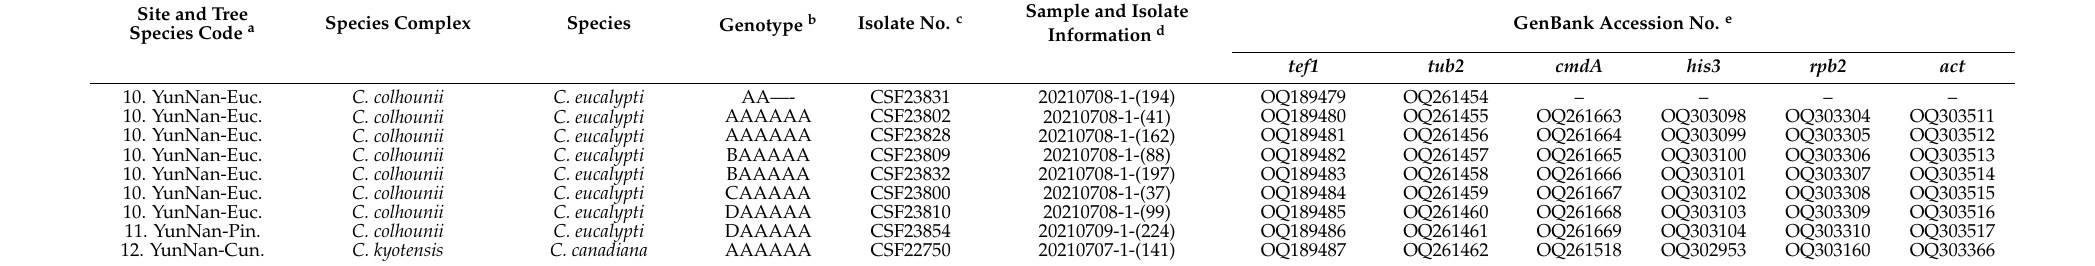
a Code of 12 sampling sites connecting to “Site and Tree species code” in Table 1. b Genotype within each Calonectria species, determined by sequences of the tef1 , tub2 , cmdA , his3 , rpb2 and act regions; “-” means not available. c CSF: Culture Collection located at Research Institute of Fasting-growing Trees (RIFT), Chinese Academy of Forestry, ZhanJiang, GuangDong Province, China. d Information associated with sample point and isolate, for example, “20210527-1-(1)” indicates sample number “20210527-1-(1)” and isolate from this sample. e tef1 = represents the relative locus was not amplified in this study.